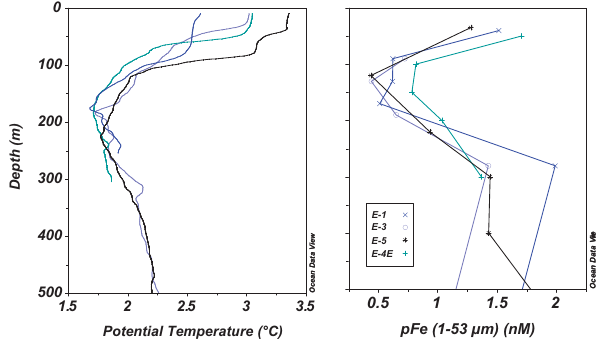
Figure 8. Temperature profiles within the upper 500m within the recirculation structure are shown alongside particulate Fe (1–53µm) within the upper 500m within the recirculation structure. Corre- spondence between the temperature minimum depth of winter water and pFe minimum is